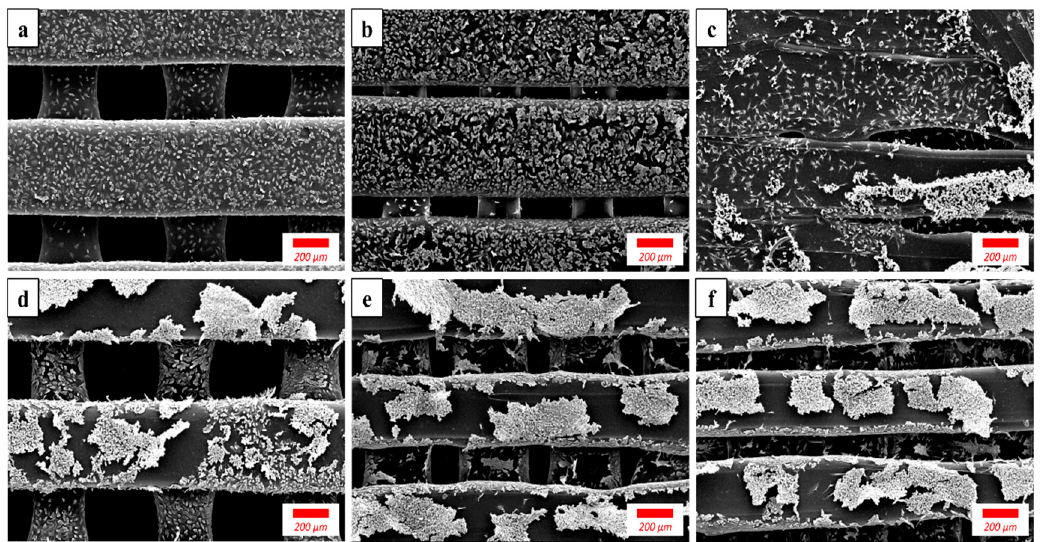
Figure 6. SEM images of preosteoblast cells grown on ( a , d ) LP, ( b , e ) SP and ( c , f ) NP membranes for ( a – c ) 1 day and ( d – f ) 3 days.